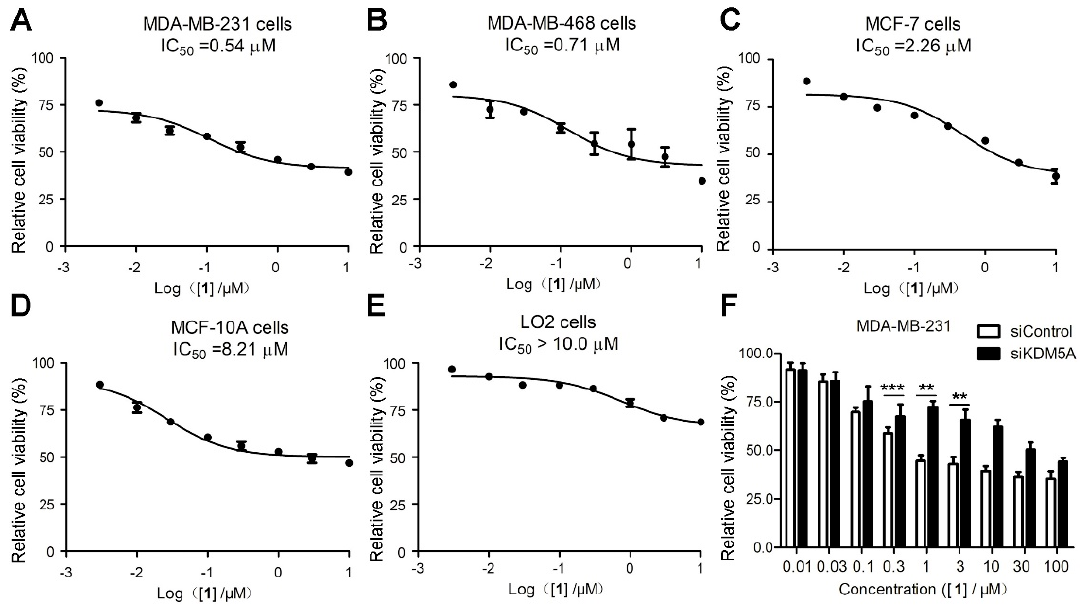
Figure 4. The cytotoxicity effect of compound 1 on breast cancer cells and normal cells. ( A ) MDA-MB-231 cells, ( B ) MDA-MB-468 cells, ( C ) MCF-7 cells, ( D ) MCF-10A, and ( E ) LO2 cells. Cells were exposed to the indicated concentrations of 1 for 72 h and cell viability was determined by MTT assay. ( F ) The cytotoxicity effect of 1 on siCon- or siKDM5A-treatement MDA-MB-231 cells. 1 inhibited the growth of on siCon- or siKDM5A-treatement MDA-MB-231 cells. Data are represented as mean ± SD. * p < 0.05, ** p < 0.01, *** p < 0.001 (Student’s t test).